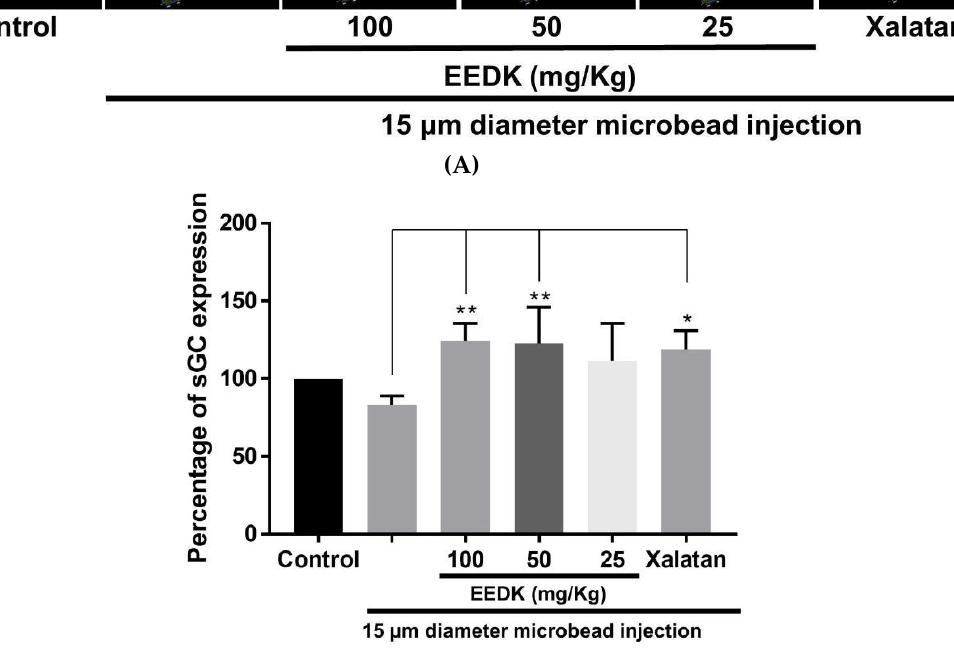
Figure 3. Effect of EEDK on sGC α -1 expression in microbeads-induced OHT mice. ( A ) Immunohistochemistry of the sGC α -1 protein expression in microbeads-induced mouse eye tissue. Expression of sGC α -1 protein and counterstaining (DAPI) are shown in green and blue colors, respectively. Scale bar = 100 µ m. ( B ) The bar graph shows quantitative analysis of the sGC α -1 expression compared with negative control. Values represent the mean ± S.E.M. for 3 animals (* p < 0.05, ** p < 0.01, mean ± S.E.M.).